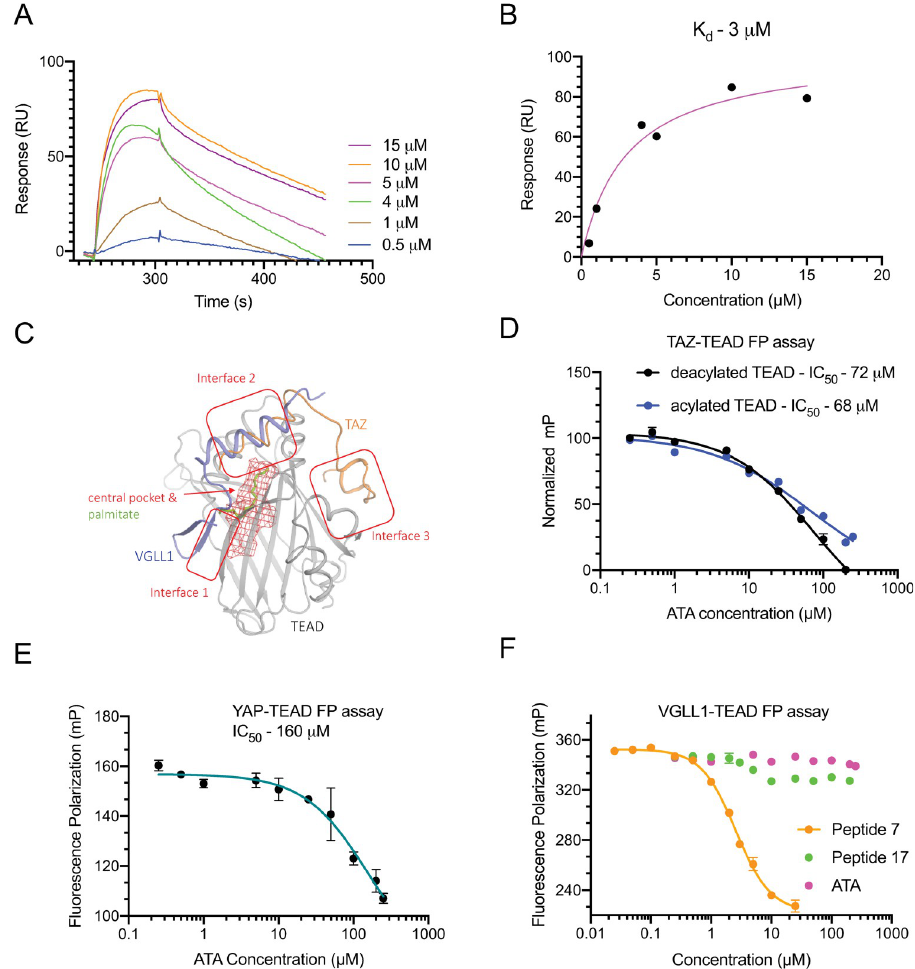
Fig 2. ATA binds to TEAD and disrupts the TAZ-TEAD interaction. A, Sensorgrams showing resonance responses that were recorded after passing the indicated concentrations of ATA over the YAP/TAZ-binding domain of TEAD. B, Affinity between TEAD and ATA was calculated by fitting a one-site binding curve to the steady-state response versus concentration. C, Cartoon showing the superposition of VGLL1-TEAD (PDB ID: 5Z2Q) and TAZ-TEAD structures (PDB ID: 5GN0). TAZ forms interfaces 2 and 3, whereas VGLL1 forms interfaces 1 and 2. The central pocket that houses the lipid is shown as a red mesh. D, Acylated and deacylated forms of TEAD were used in a TAZ-TEAD FP assay to characterize whether ATA binds to the surface or the central pocket of TEAD, the IC 50 values were obtained through a four-parameter curve fit. E, YAP-TEAD FP assay using a YAP peptide probe to evaluate whether ATA disrupts the formation of the YAP-TEAD complex. F, Vgll1-TEAD FP assay using a mouse Vgll1 peptide probe to monitor whether ATA binds at interfaces 1 and 2. Peptide 7 was used as a positive control and peptide 17 was used as a negative control. All FP experiments were repeated three times using technical duplicates with similar outcome. The data is shown as mean (n = 2) and error bars represent standard deviation of the mean.